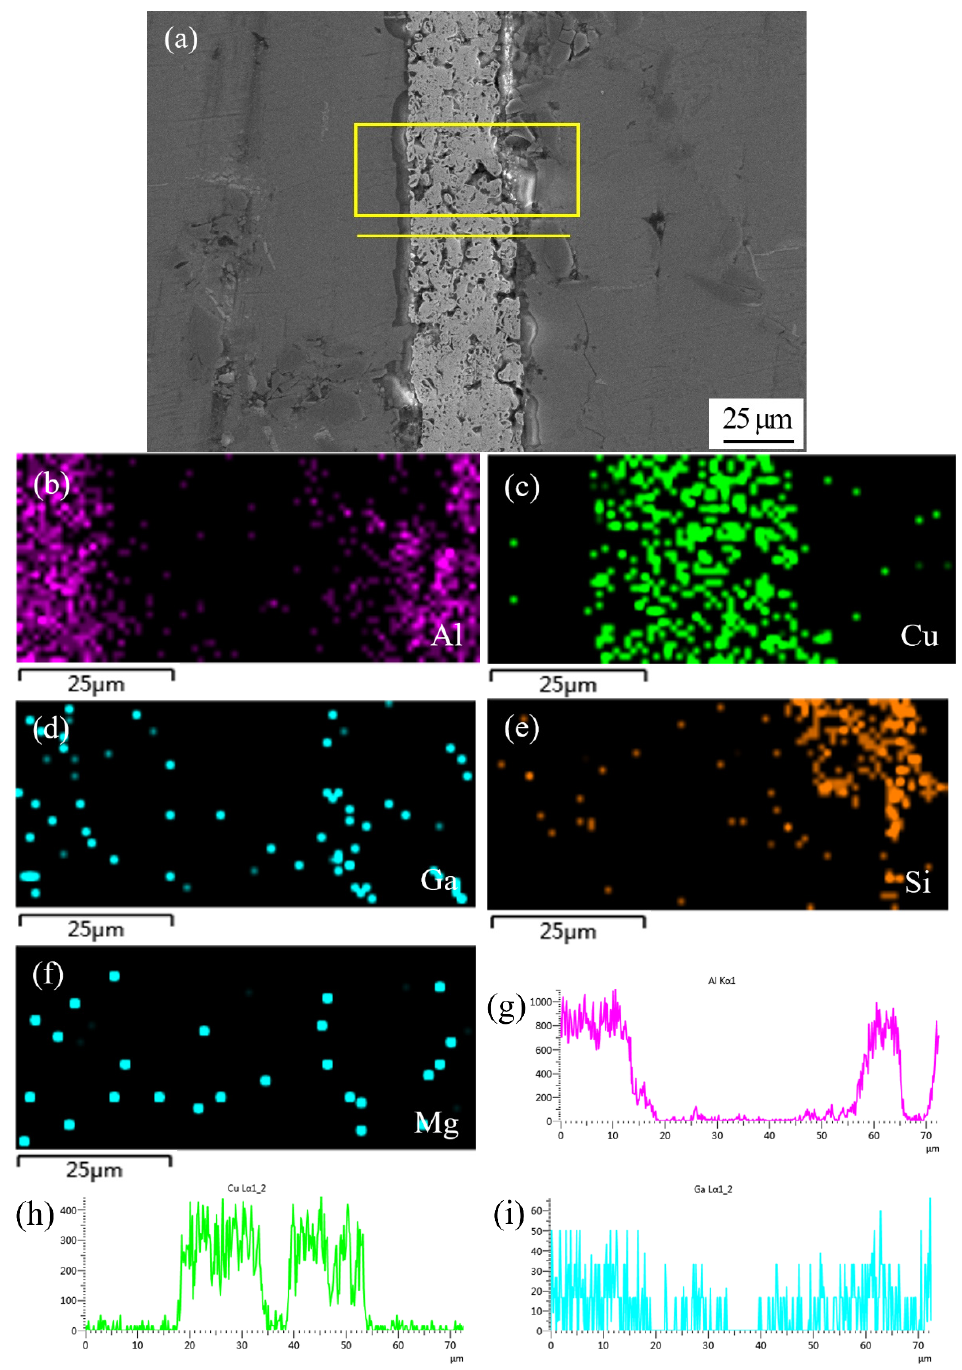
Figure 7. SEM micrograph at the interface of SiC p /6063 Al MMCs joint sintering bonded at 450 °C using Cu NPs and liquid Ga, and the corresponding energy dispersive X-ray maps showing distri- bution of elements: ( a ) SEM image; ( b – f ) individual elemental mapping of Al, Cu, Ga, Si and Mg, respectively; ( g – i ) line scanning profile of elements Al, Cu and Ga, respectively.